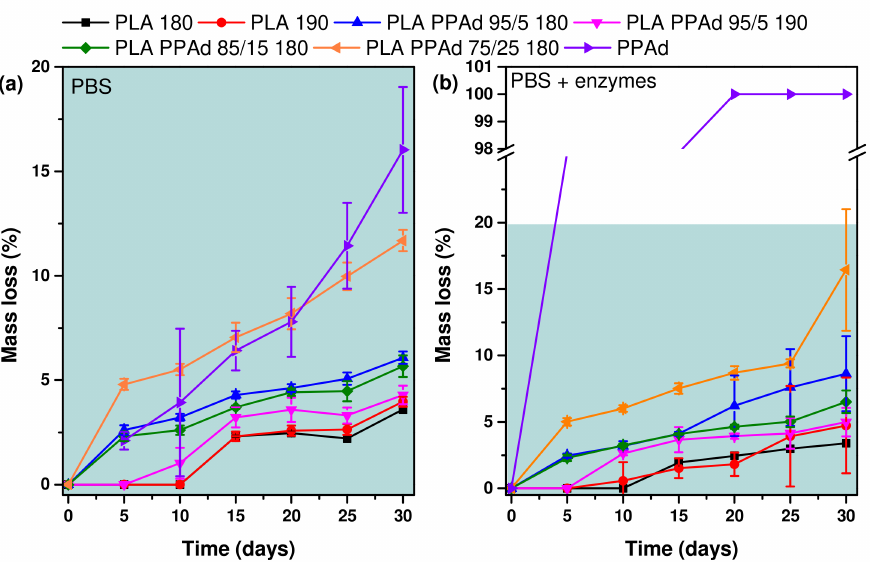
Figure 10. % Mass loss of the samples during incubation at 37 ◦ C in ( a ) PBS and ( b ) PBS with enzymes (0.01 mg/mL lipase from Pseudomonas cepacia and 0.1 mg/mL lipase from Rhizopus oryzae ). The shaded sections correspond to 20% mass